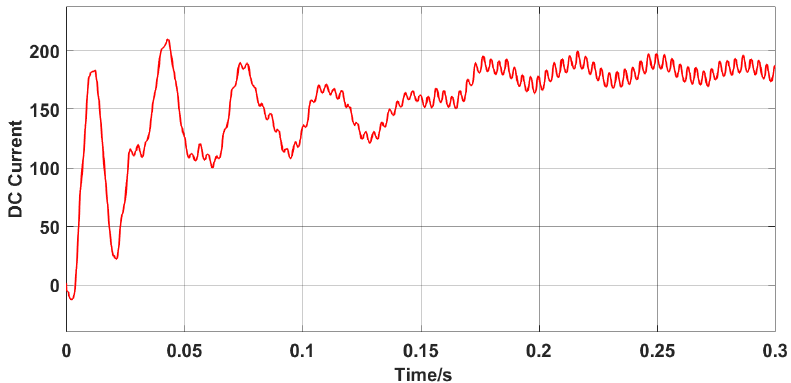
Figure 9. DC side ’s current. Figure 9. DC side’s